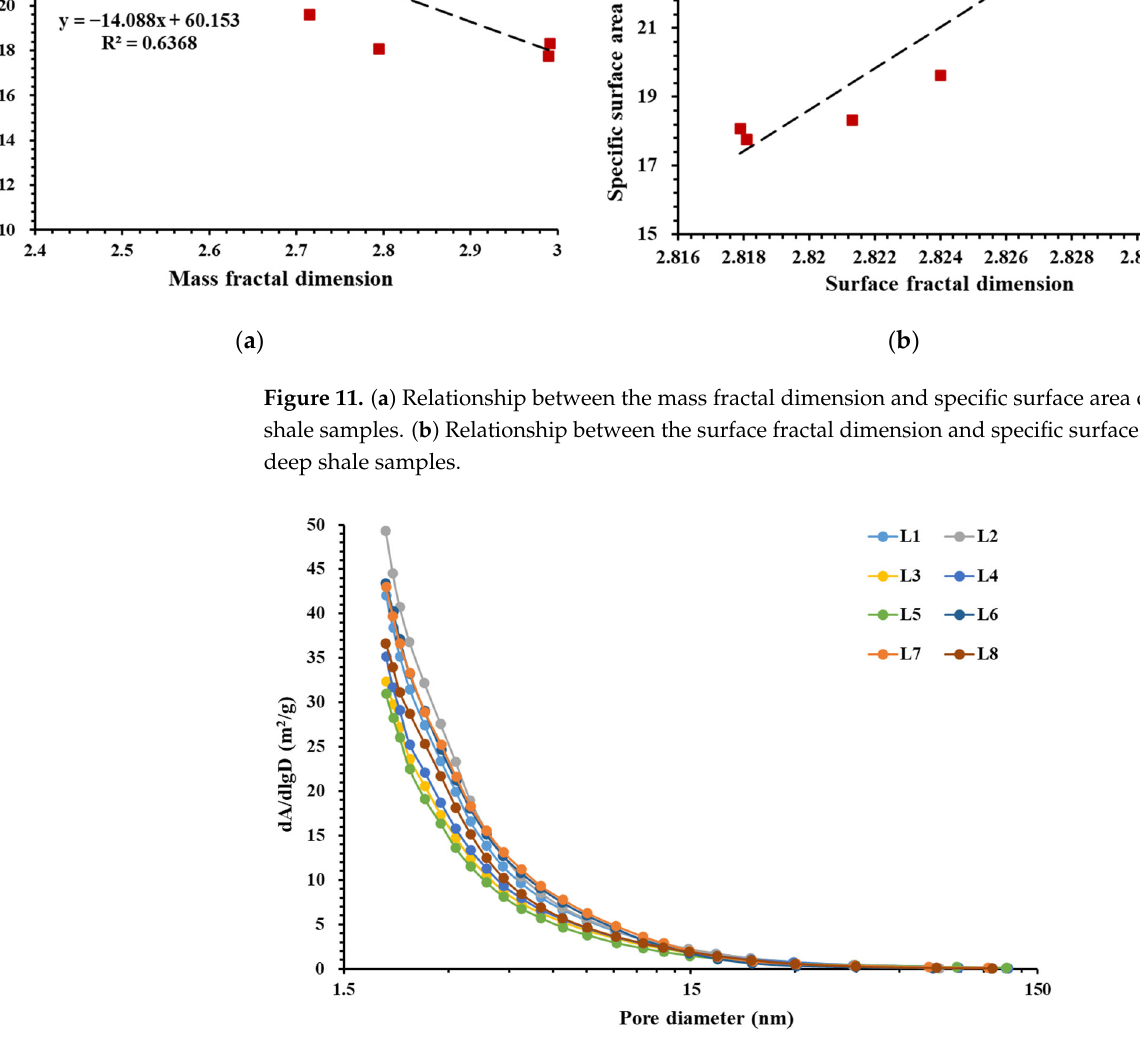
( b ) Figure 13. ( a ) Relationship between the mass fractal dimension and burial depth of the deep shale samples. ( b ) Relationship between the surface fractal dimension and burial depth of the deep shale samples. 4.3. The Relationship between Mass Fractal Dimension and Surface Fractal Dimension The roughness of the pore surface of the rock is characterised by the surface fractal, and the distribution features of the rock pores are characterised by the mass fractal. There ‐ fore, conceptually, both the surface fractal features and mass fractal features can exist in